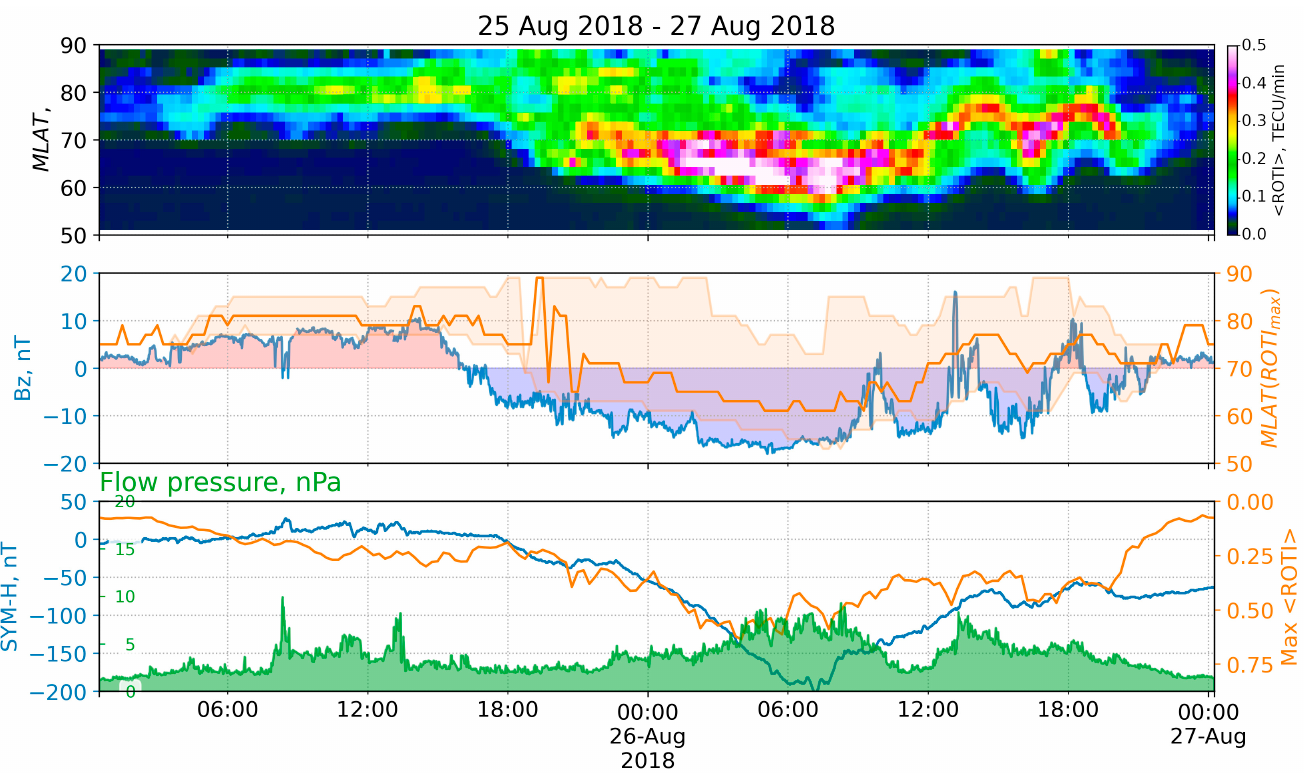
Figure 9. ROTI keogram and space weather parameters for the storm of 25–26 August 2018: ( top ) keogram of average ROTI (<ROTI> versus MLAT versus time); ( middle ) IMF Bz ( blue ), MLAT positions of maximum <ROTI> ( orange ), and values exceeding median ROTI at the moment ( orange filling ); ( bottom ) SYM-H index ( blue ), <ROTI> max ( orange ), and flow pressure ( green ).